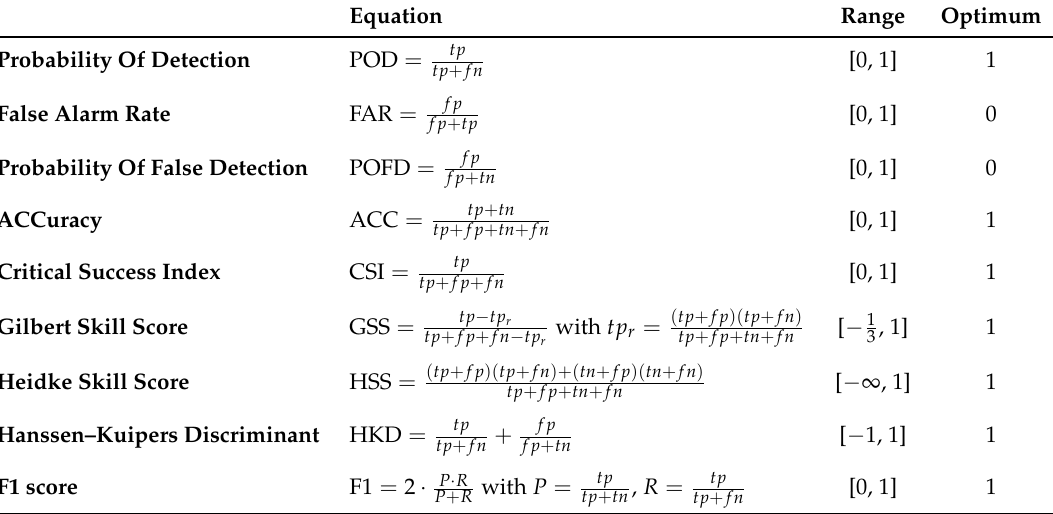
Table 4. The classification scores equation, value range and optimum value. The F1 score is calculated from the precision P and the recall R .